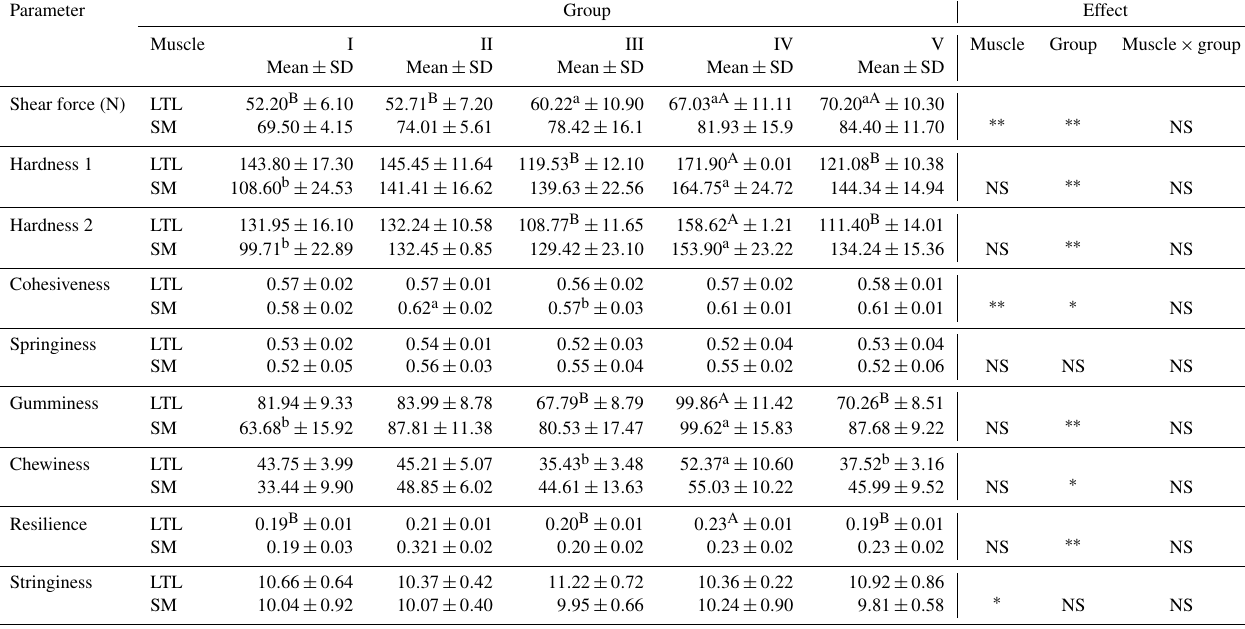
Table 3. Texture parameters of meat from female wild boars ( Sus scrofa scrofa L.) of different carcass weights.